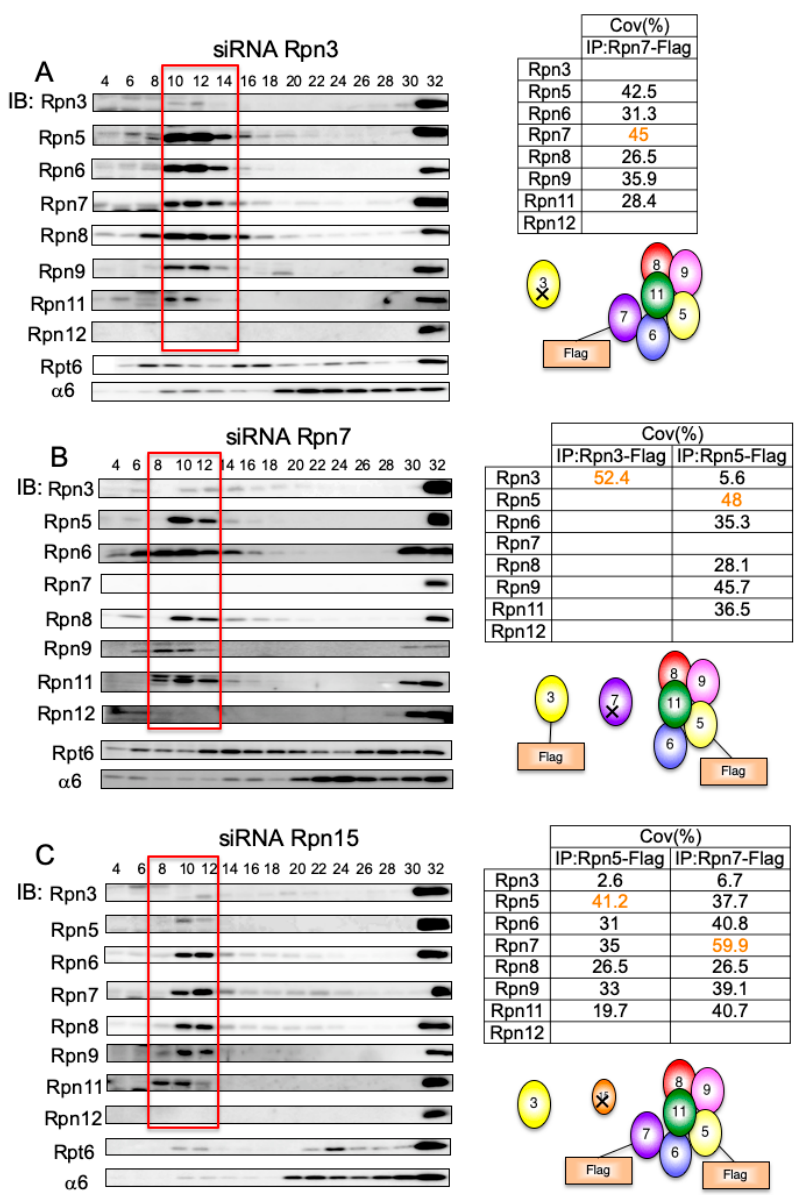
Figure 6. The Rpn7–Rpn6 interaction connects the Rpn3-7-15 module with the Rpn5-6-8-9-11 module. HEK293T cells stably expressing Rpn7-Flag treated with siRNA targeting Rpn3 ( A ), cells stably expressing Rpn3-Flag and Rpn5-Flag treated with siRNA targeting Rpn7 ( B ), and cells stably expressing Rpn5-Flag and Rpn7-Flag treated with siRNA targeting Rpn15 ( C ) were analyzed in the same way as described in Figure 2. The tables show the sequence coverage of the identified